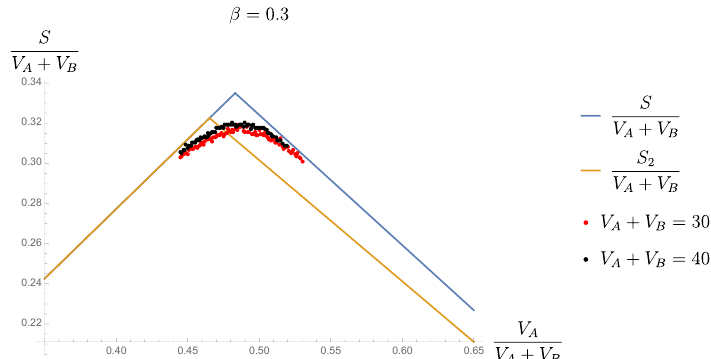
Figure 33 . Numerical evaluation of the von Neumann entropy of A with I α as in (F.1) using the resolvent (F.3). We can see that the Page transition occurs at the point predicted by (2.50) and not at, for instance, the transition for the second Renyi entropy from (F.2). For simplicity, we have used a Gaussian density of states ρ ( E ) ∝ exp